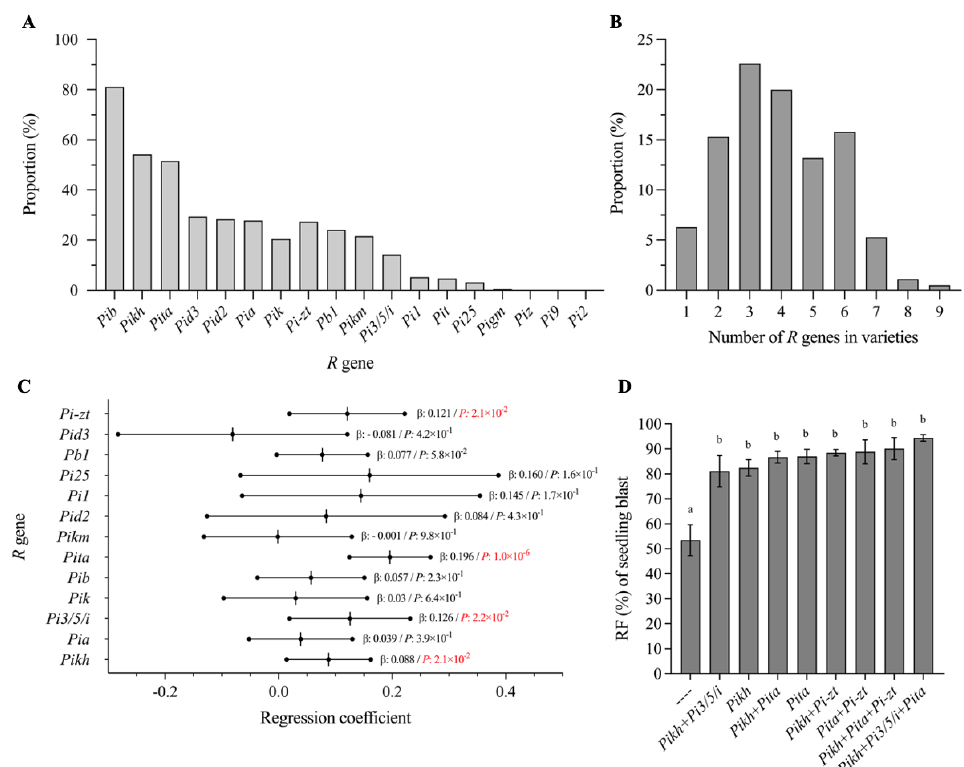
Figure 2. Distribution of 18 R genes in Jiangsu Geng rice varieties and analysis of elite R genes and R -gene combinations for seedling blast resistance. ( A ) Distribution frequency of 18 R genes in Jiangsu Geng rice varieties. ( B ) Distribution frequency of varieties that contain different numbers of R genes. ( C ) Multiple linear regression analysis of the contribution of each R gene and seedling blast resistance. “ β ” represents the regression coefficient. Red texts indicate that the contribution of a corresponding R gene to seedling blast resistance has reached a significant level ( p < 0.05). ( D ) Correlation between RF and different elite R genes or R -gene combinations in seedling blast resistance. Different lowercase letters indicate significant differences according to Duncan ’s multiple range tests ( p < 0.05).